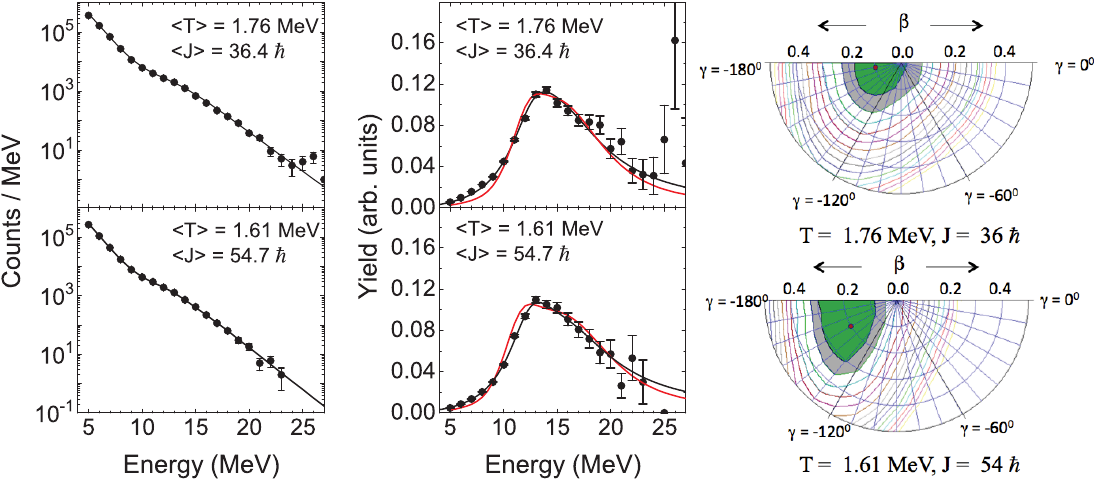
Figure 2. (Left) GDR γ ray energy spectra at di ff erent average spin ( J ) and temperature ( T ) values, and (middle) the linearised plot for the same are shown. Red line represents GDR cross sections calculated by TSFM whereas black lines are CASCADE calculations. TSFM cross sections were normalized with respect to CASCADE cross sections. (Right) Potential energy surfaces of the nucleus 144 Sm at di ff erent J and T with a contour line spacing of 0.5 MeV. The filled circle represents the equilibrium shape and the first two minima are